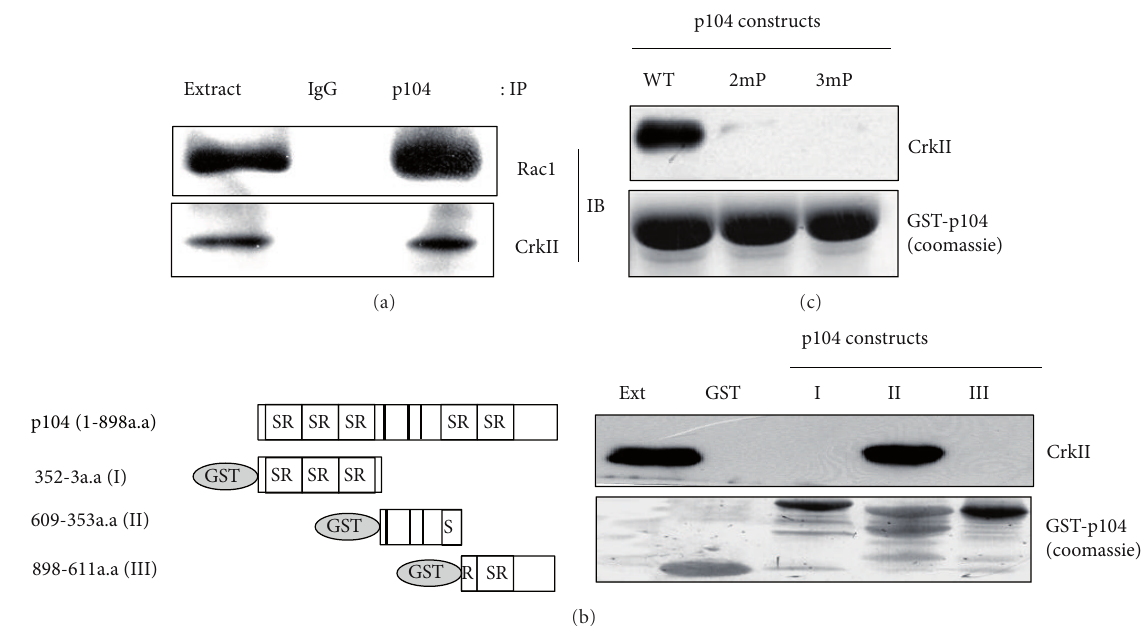
Figure 3: p104 was specifically associated with Rac1. (a) p104 interacted with CrkII as well as Rac1. After immunoprecipitation was performed with the p104 antibody, the presence of CrkII and Rac1 in the precipitated immune complex was analyzed by Western blot with anti-CrkII and anti-Rac1 antibodies, respectively. (b) CrkII and Rac1 bind to distinct regions of p104. GST-fused p104 I, II, and III proteins linked to glutathione-SepharosebeadswereincubatedwithmousebrainextractandthenboundproteinswereanalyzedbyWesternblotwithantibodies against CrkII and Rac1. (c) p104 directly interacts with CrkII through the proline-rich region. Mouse brain extract was incubated with GST- p104 (WT, wild type), GST-2mp (second proline-rich motif mutant), and GST-3mp (third proline-rich motif mutant) immobilized onto glutathione-Sepharose beads. Bound proteins were analyzed by Western blot with an anti-CrkII antibody. A coomassie brilliant blue stained SDS-PAGE gel showed that equal amounts of fusion proteins were